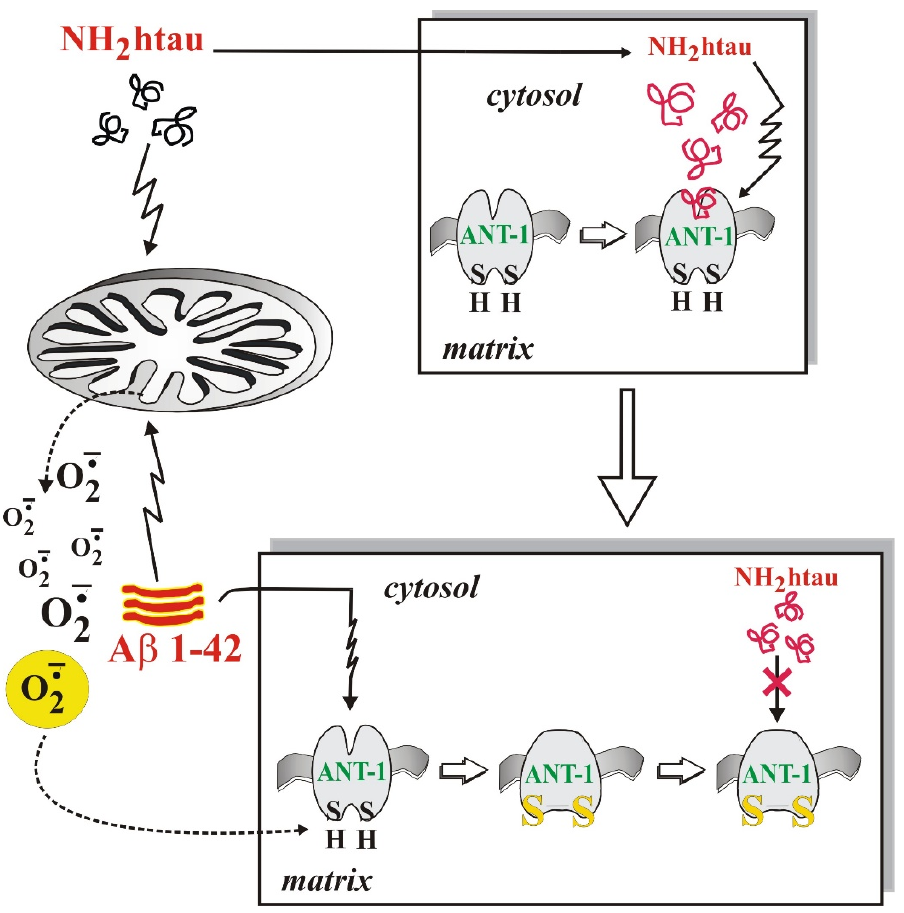
Figure 1. Both thiol groups present at the ANT active site and the A β 1–42-induced ROS increase, which can oxidize these –SH residues underlying the pathological A β -NH 2 htau interplay on ANT-1 in AD. In the upper panel, the NH 2 htau fragment affects ANT-1 without interacting with A β . In the lower panel, A β induced-ROS production oxidizes ANT-1 thiol/s, thus modulating NH 2 htau toxicity.